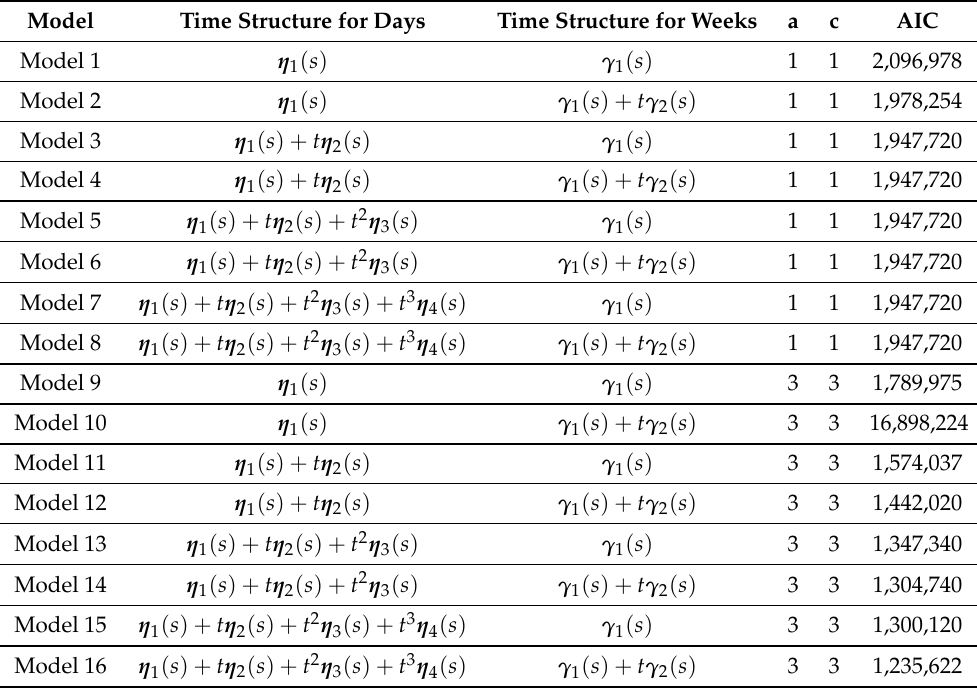
Table 4. Comparison of AIC for selection of ridge weights and time structures.